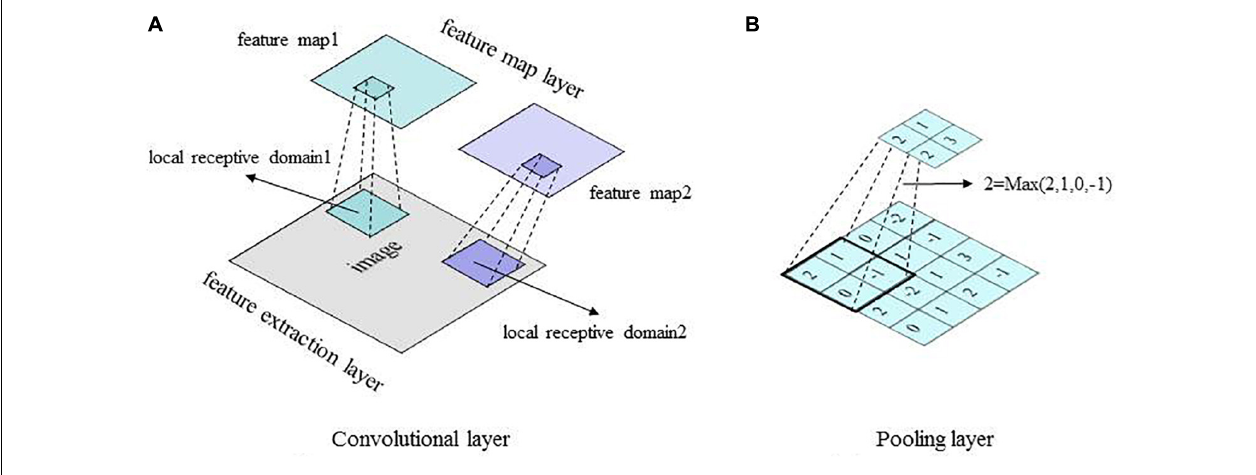
FIGURE 3 | Basic structures of the CNN convolutional layer and pooling layer. (A) Convolutional layer. (B) Pooling